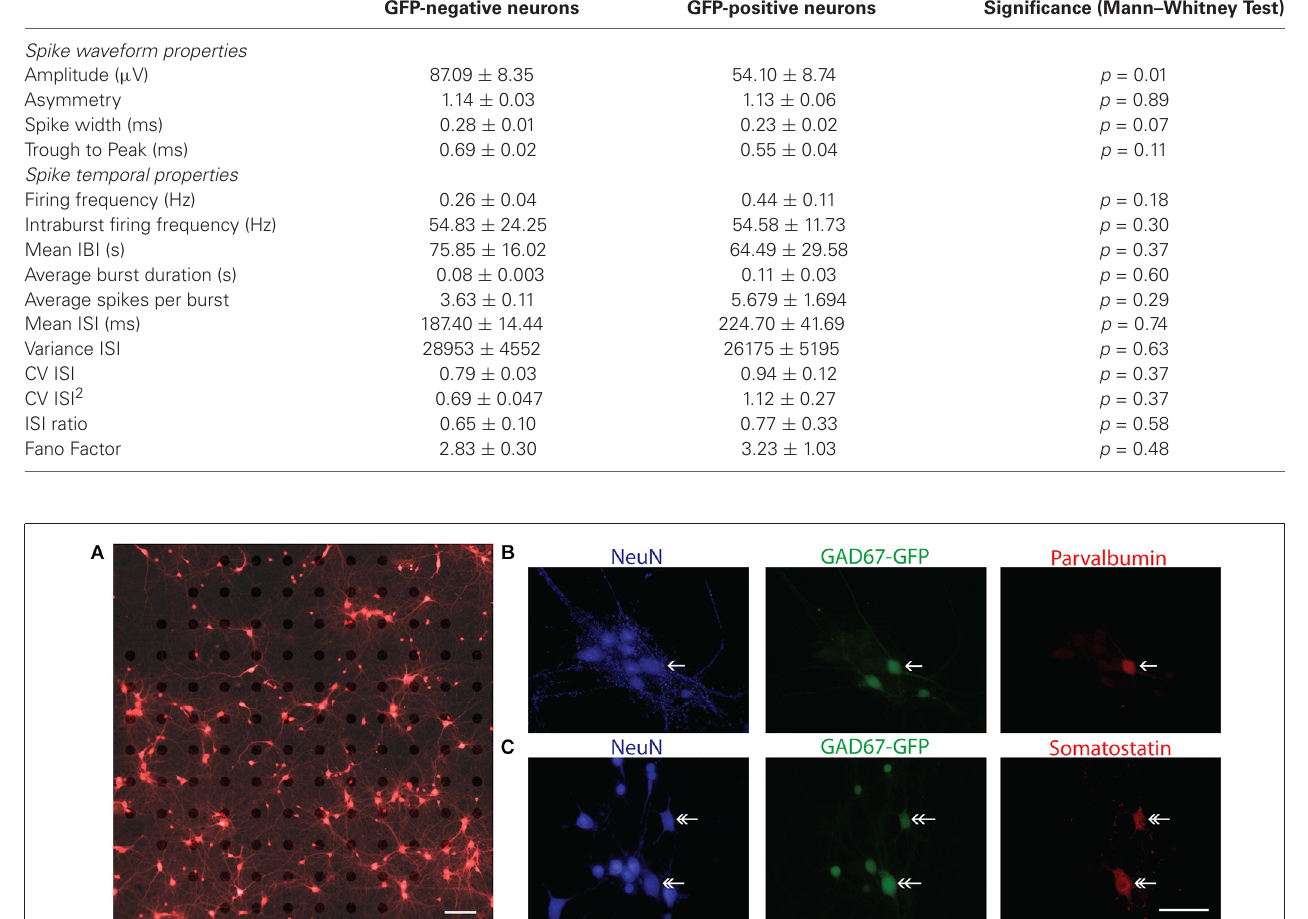
FIGURE 2 | Characterization of sparse cortical cultures. (A) Overlay of brightfield and fluorescence images of calcein red-orange stained cells sparsely cultured on a 120-channel MEA recorded at 14 DIV. Note, electrodes are visible in brightfield image. In this example, 186 neurons were detected in the field of view by our imaging analysis and 13 unique spike waveforms